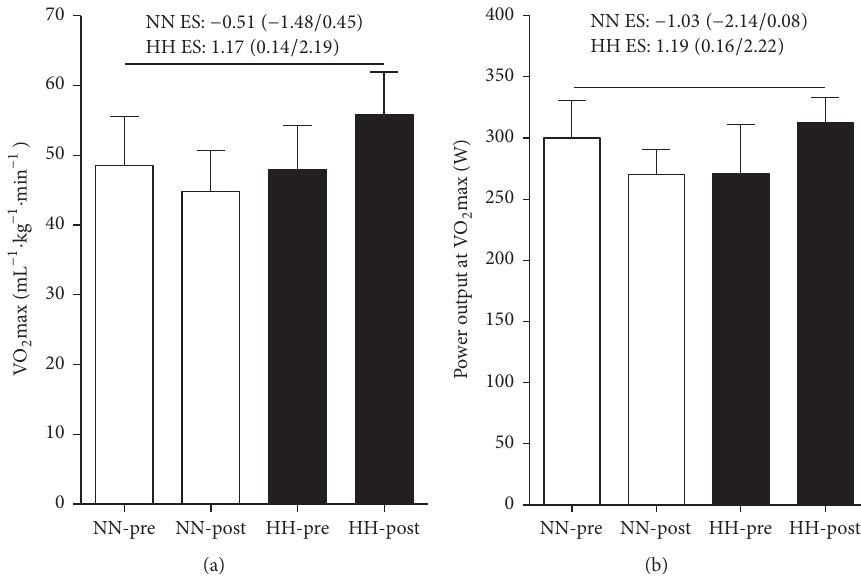
Figure 2: Effects of 3 weeks of NN and HH endurance training on VO 2 max (a) and peak power output (b) in young soccer players. ES: effect size. NN = normobaric normoxia; HH = hyperbaric